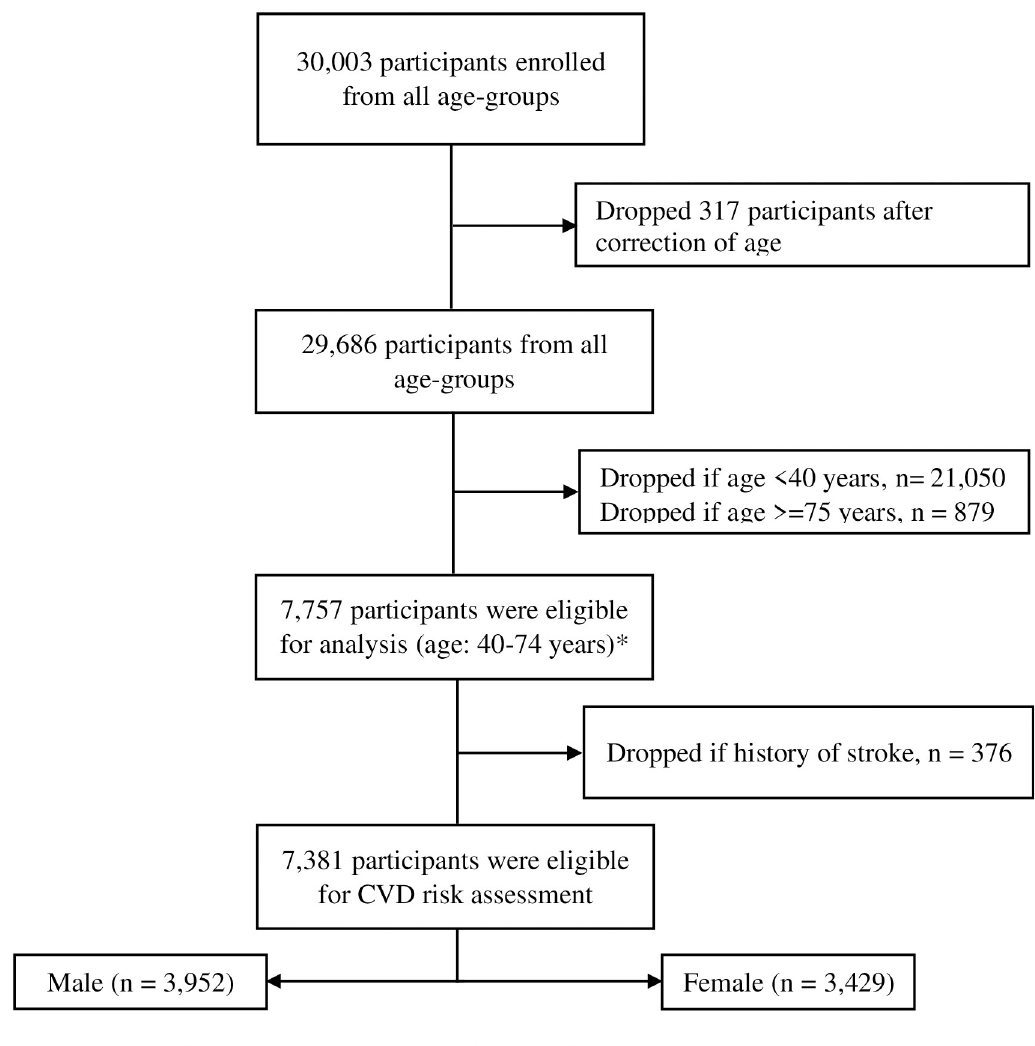
Fig 1. Diagram showing the process of extracting eligible